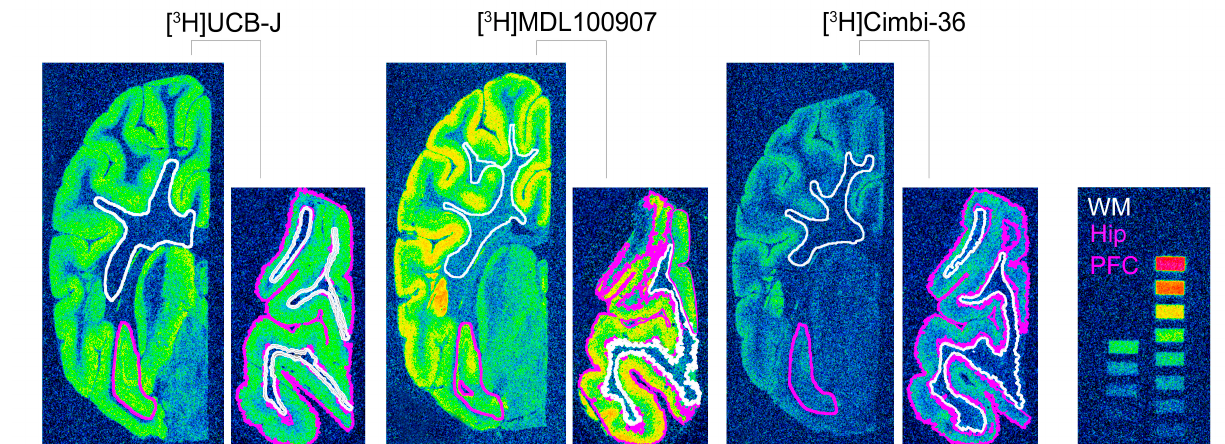
Figure 4. Representative autoradiograms of the radioligands used in this study. Half hemisphere sections of the hippocam- FIGURE 4 pus (larger coronal sections) and PFC (smaller coronal sections) from the same animal belonging to the Saline: 1 day group. The color-coded lines show representations of the region of interest that were either hand-drawn or drawn using the wand tool in ImageJ and visually inspected. The figure also shows the radioactive standards used in the study; approximately 16 nCi/mg to 0.2 nCi/mg decay corrected to the time of experiment and day of